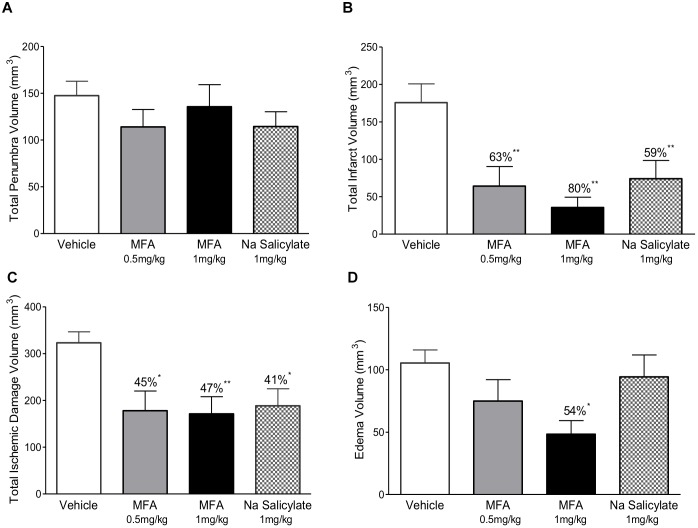
Mefenamic acid and sodium salicylate are neuroprotective in the rodent transient MCAO model. The histograms show (A) penumbra volume, (B) infarct volume, (C) total ischemic damage (TID) and (D) edema volume in animals treated with either MFA (0.5 or 1 mg/kg), sodium salicylate (1 mg/kg) or vehicle control. Drugs were infused into the left lateral cerebral ventricle by osmotic mini pump for 24 h beginning 1 h prior to MCAO. MFA significantly reduced infarct, edema, and TID; salicylate also reduced infarct and TID but the penumbra volume was not reduced in any of the treatment groups. Values are expressed as mean ± SEM for n = 8 in each group. ∗p ≤ 0.05; ∗∗p ≤ 0.01.